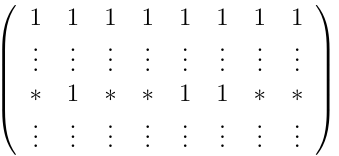
for near-MDS matrix M of order n with 5 ≤ n ≤ 8 1